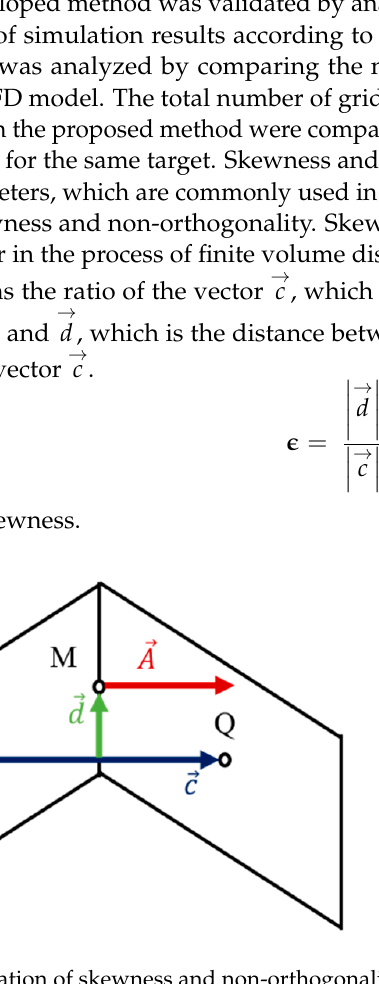
Figure 4. Estimation of skewness and non-orthogonality. Non-orthogonality is defined as the angle between vector ( center points of two cells, and normal vector ( of two cells. Non-orthogonality is calculated, as shown in Equation